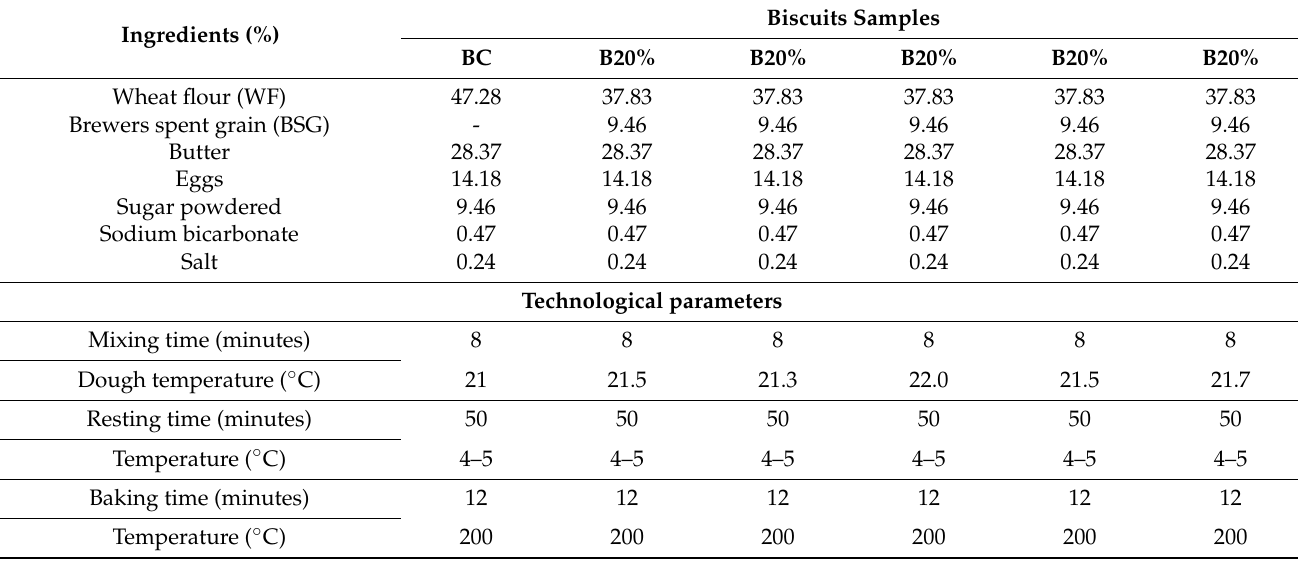
Table 11. Cookie’s ingredients and technological